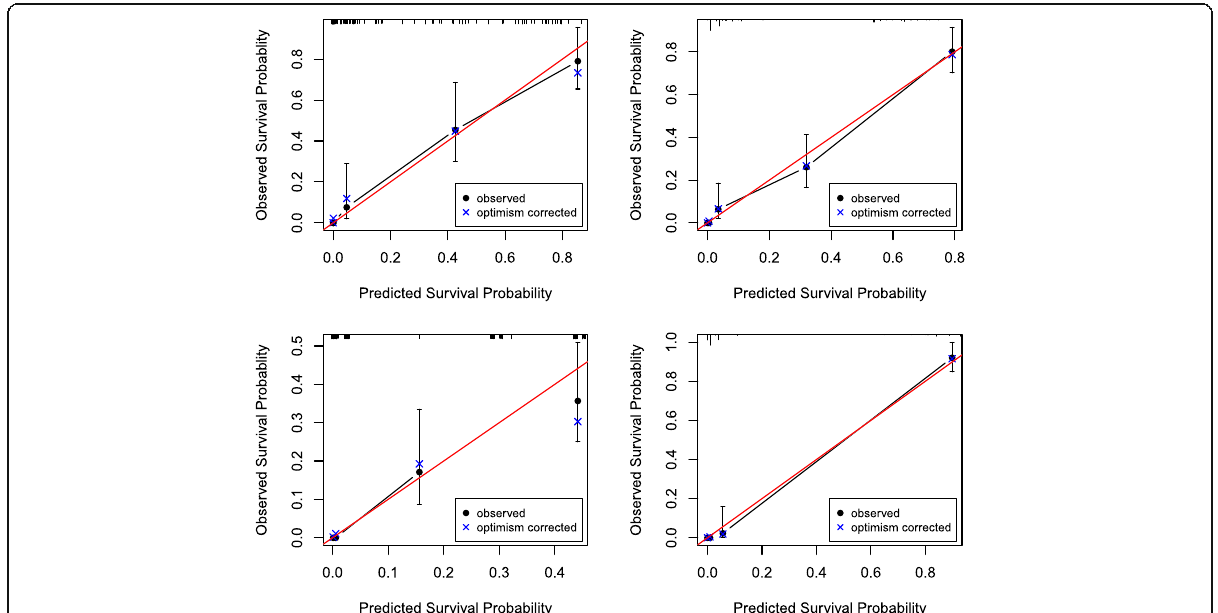
Fig. 3 Calibration plots on training set for observed survival probability at 2 years versus predicted survival for a ALASSO with n = 150 and weak signal strength, b ISIS-ALASSO with n = 150 and weak signal strength, c ISIS-LASSO when n = 150 and strong signal strength, and d ISIS-LASSO when n = 300 and strong signal